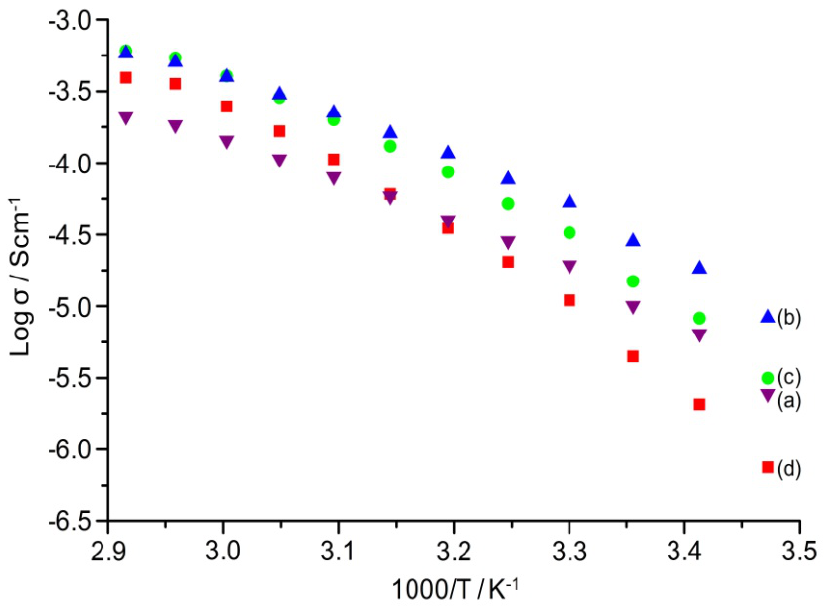
Figure 8. Temperature dependence of ionic conductivity of TIE(2000)-Z hybrid electrolytes with Z = ( a ) 32; ( b ) 24; ( c ) 16 and ( d )